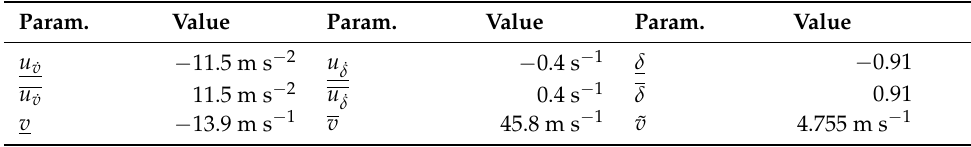
Table 1. Parameters of the optimization problem (18). Param. Value Param. Value